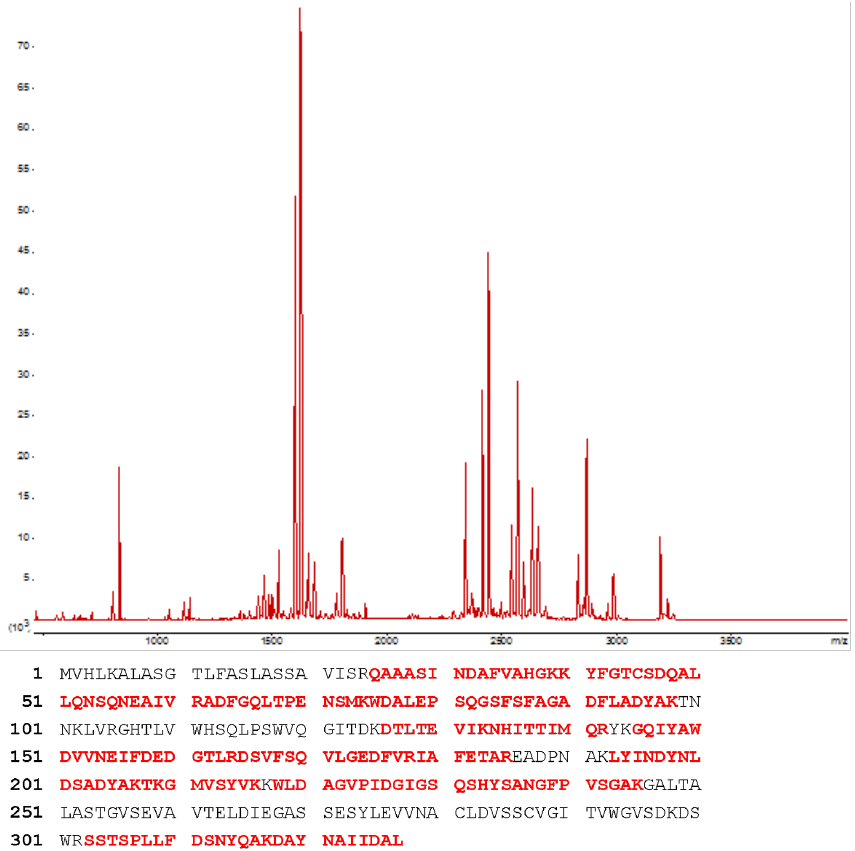
Figure 4. Mass-spectrometry MS1 analysis (verified amino acids of xAor are highlighted red) (Protein accession number: O94163 Endo-1,4-beta-xylanase Aspergillus oryzae RIB40). Thus, mass-spectrometry of the studied sample showed the identity of the primary target sequence compared to the predicted one ( p ≥ 0.95).